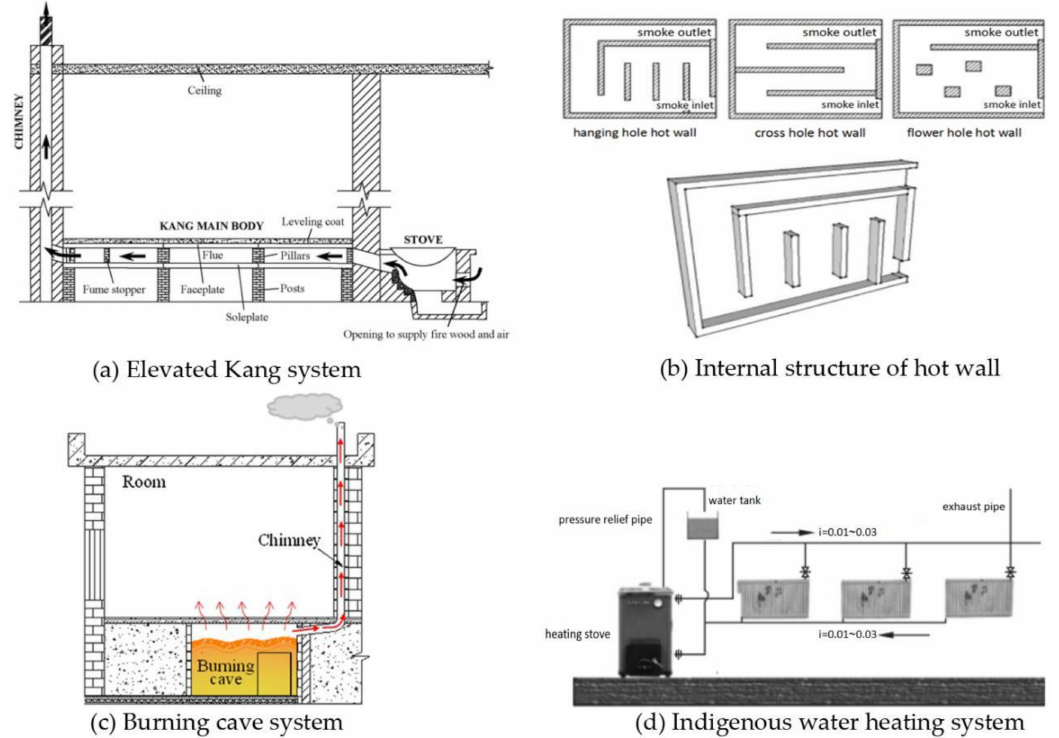
Figure 1. Schematic diagrams of traditional rural heating